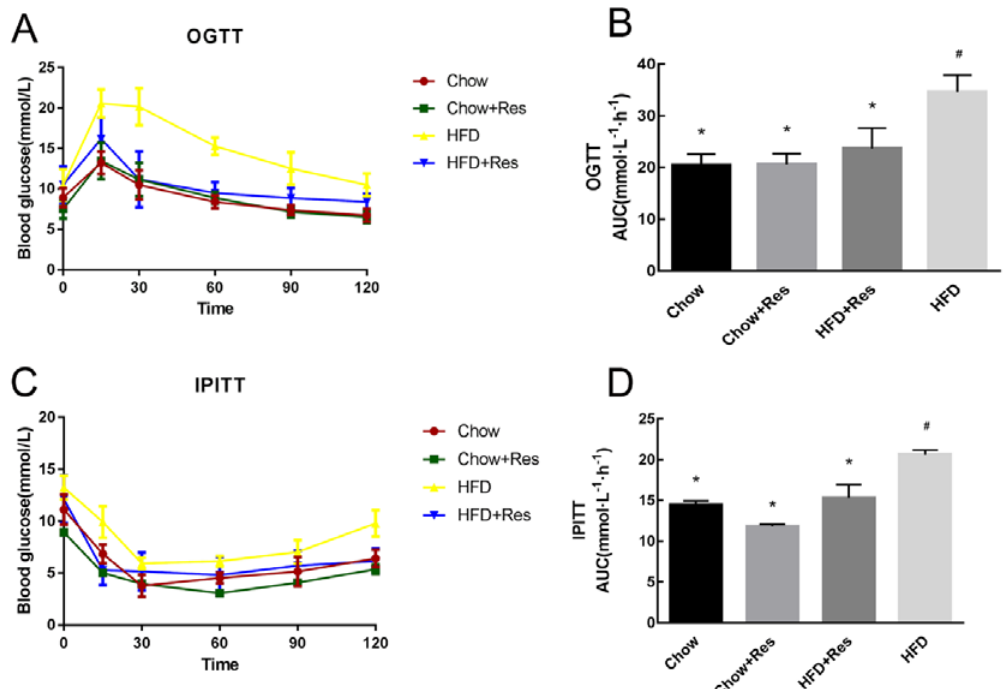
Figure 2. Resveratrol (RES) modulated glucose homeostasis. ( A ) Blood glucose levels and ( B ) Areas under the curve (AUC) during the oral glucose tolerance test (OGTT). ( C ) Blood glucose levels and ( D ) AUC during the intraperitoneal injection of insulin tolerance test (IPITT). * p < 0.05; compared with HFD-CT, # p < 0.05; compared with NCD-CT, ( n = 5/group).